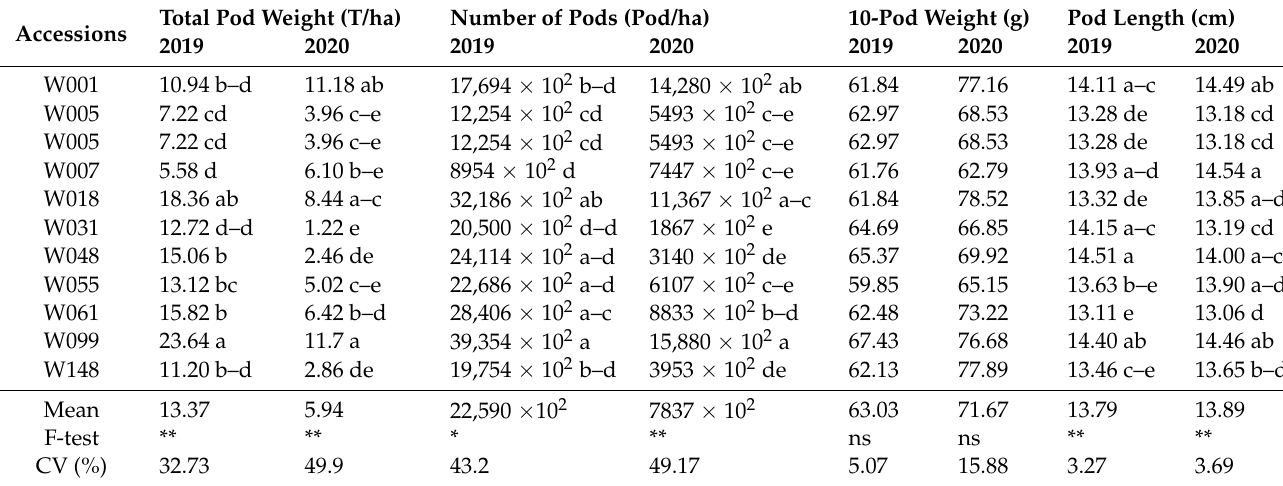
Table 2. Variability of winged bean total pod weight, number of pods, 10-pod weight, and pod length of ten accessions evaluated across two years under rainy season conditions at Khon Kaen University in 2019 to